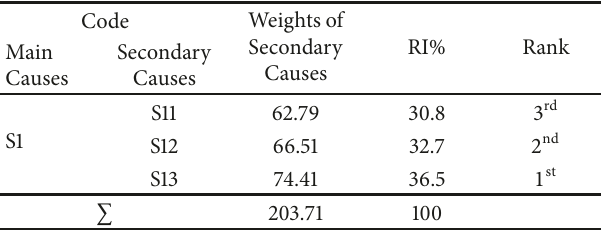
Table 6: Main causes weights, relative importance, and rank for project design management process group.